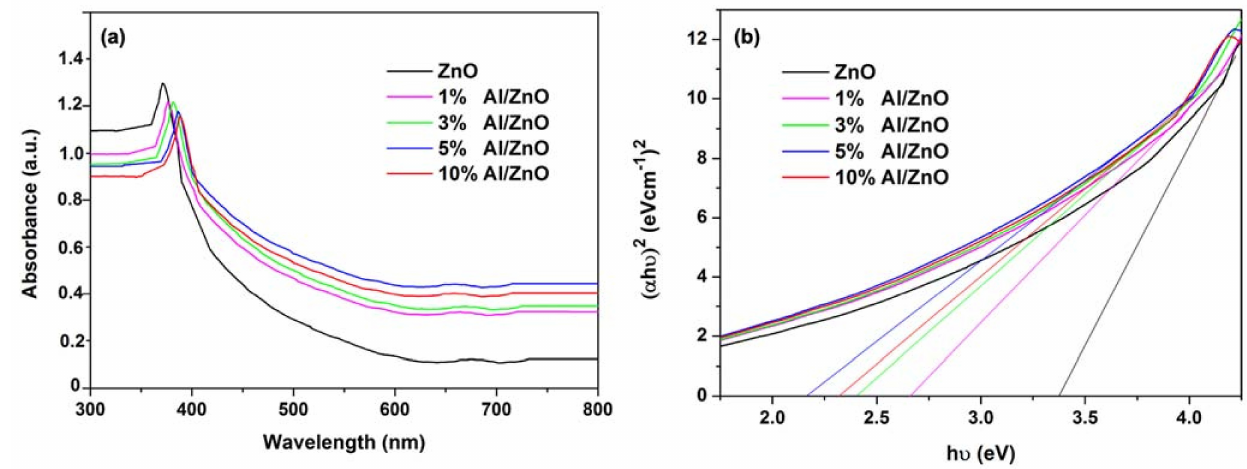
Figure 4. ( a ) Absorption spectra of ZnO and Al/ZnO photocatalysts analyzed by UV–Vis spectrophotometer; and ( b ) Tauc plots of energy band gap for ZnO and Al/ZnO